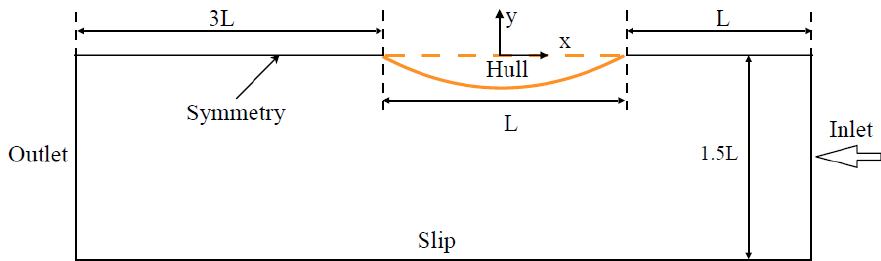
Figure 2. Top view of the layout ( z = 0) of the computational domain with − 1.5 L < x < 3.5 L , 0 < y < 1.5 L , − 1.5 L < z < 0.5 L . The direction of x axis is opposite to the incoming flow, y axis is parallel to the free surface, the direction of z axis is opposite to the gravity.